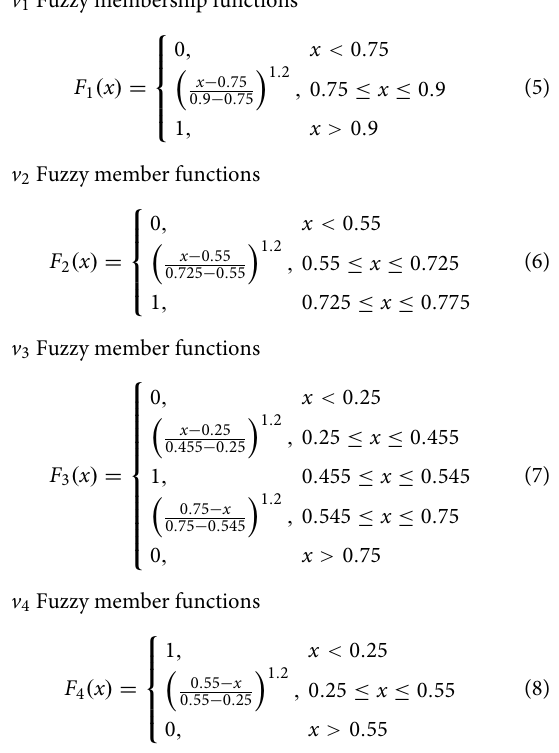
v 1 Fuzzy membership